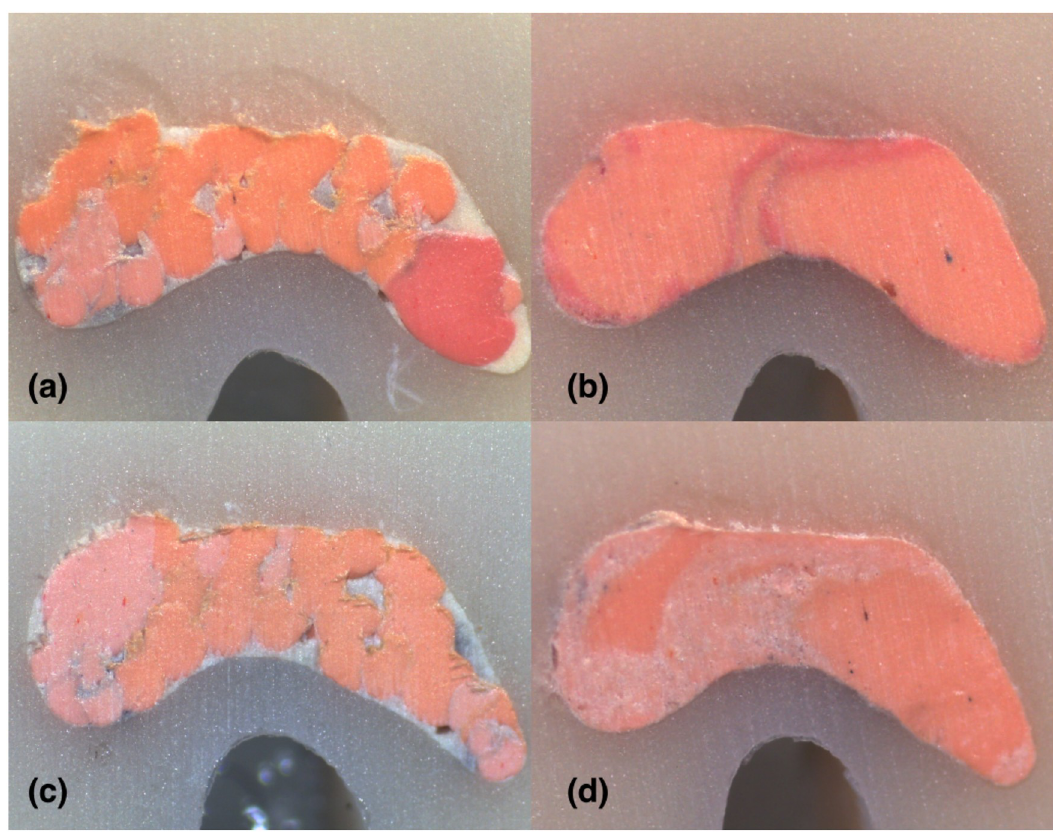
Fig 6. Stereomicroscope images of 6 mm sections instrumented with Hyflex EDM: (A) LC (B) CW; Stereomicroscope images of 6 mm sections instrumented with Reciproc Blue: (C) LC (D) CW in C1-type.